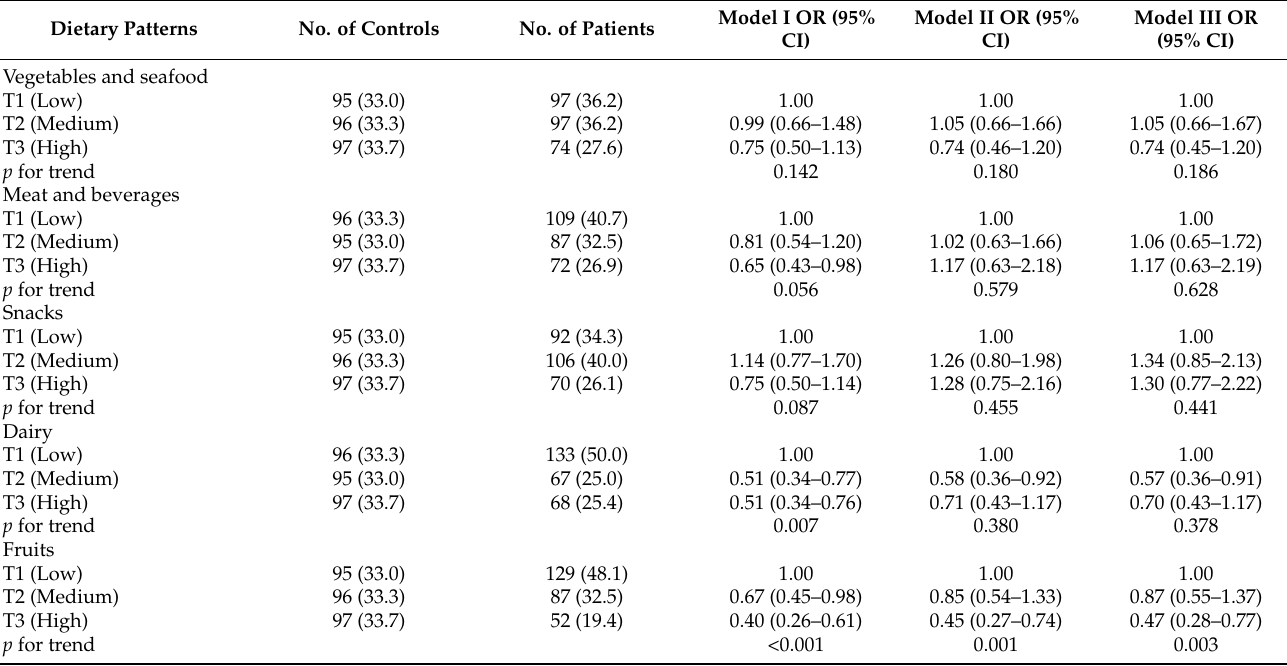
Table 2. Association between dietary pattern networks derived from GGMs and the GC risk in the total population. Dietary Patterns